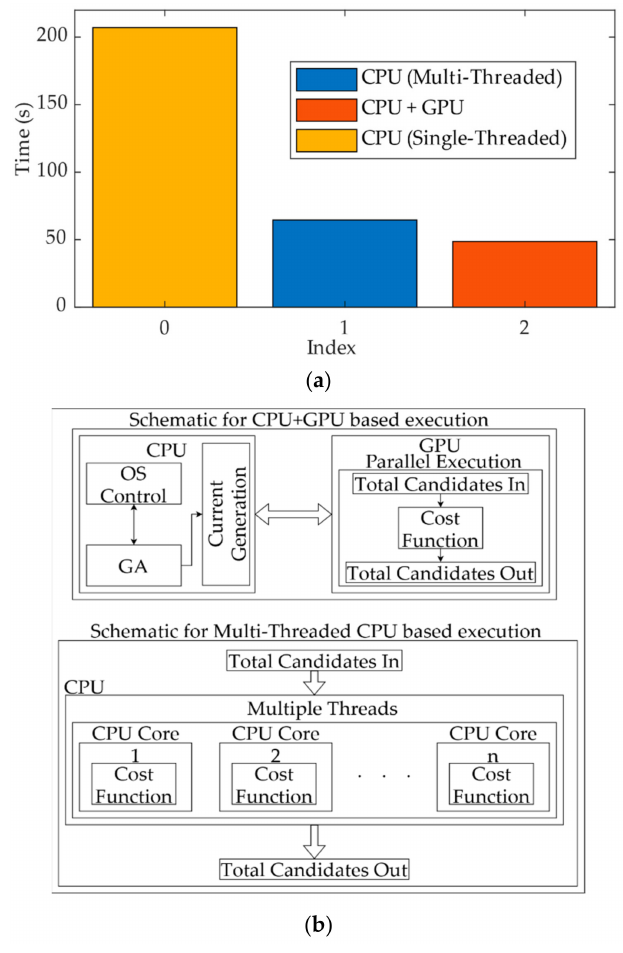
Figure 10. Genetic algorithm implementation workflow: ( a ) GA execution time for a simulated real-world cycle; ( b ) schematic for CPU + GPU, and multi-threaded CPU-based